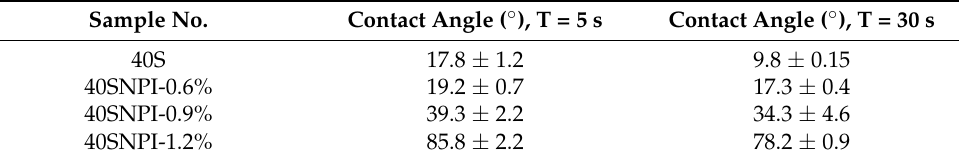
Table 5. Contact angle of cement pastes. Sample No.